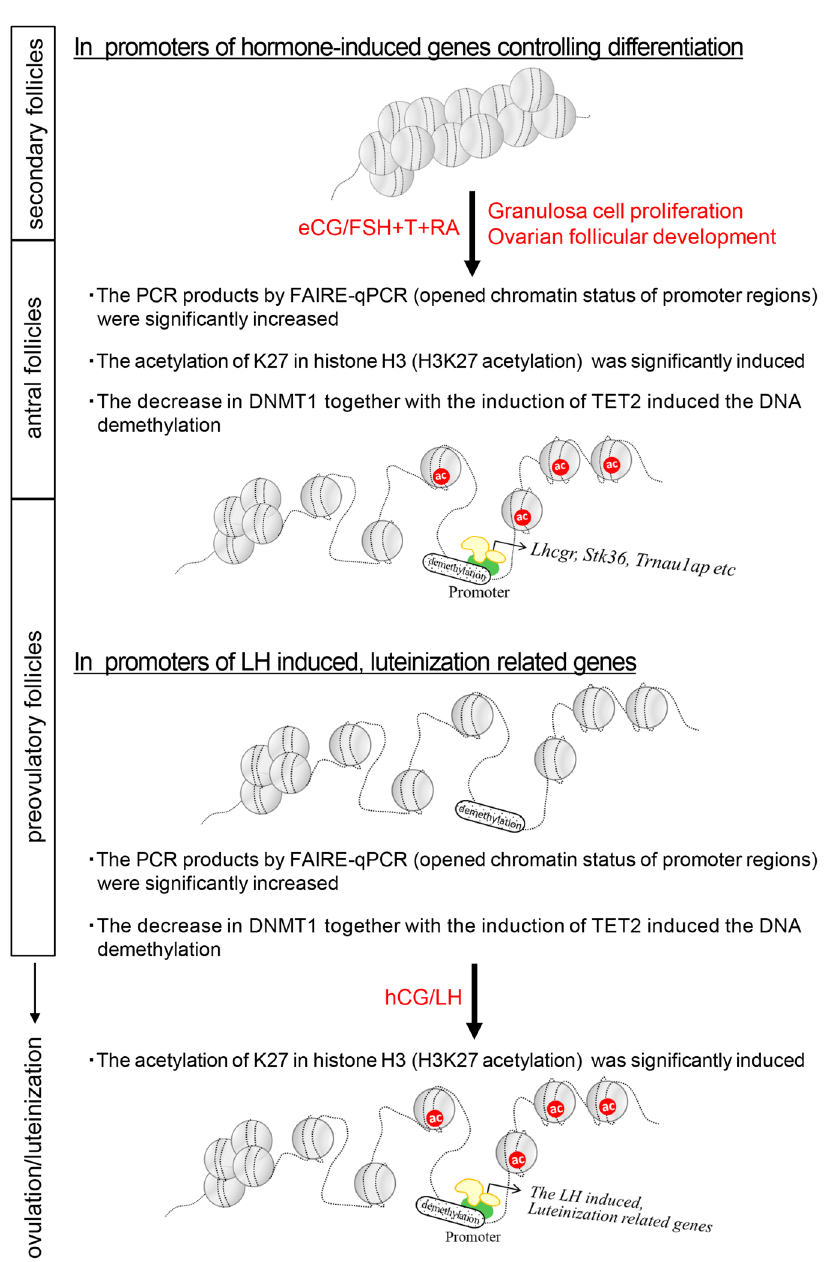
Fig. 7 The roles of retinoic acid (RA) in epigenetic regulation in granulosa cells during follicular development. a The expression of Ccnd2 , Dnmt1 , Tet2 , Lhcgr , Stk36 , and Trnau1ap in cultured granulosa cells. Granulosa cells were collected from ovaries of 3-week-old mice after treatment with eCG for 6 h and were cultured in the absence of serum. FSH (100 ng/ml). T, testosterone (10 ng/ml). RA (1 μ M). Levels of mRNA were normalized to that of L19 . Values are represented as the mean ± SEM ( n = 3 biological replicates). The value of the control (without any factors) was set as 1 and the data are presented as fold induction. *Signi fi cant differences were observed between the control group and the RA and/or FSH + T treatment group ( p < 0.05). b , c The percentage of cells that expressed lower levels of DNMT1 was signi fi cantly increased by RA but decreased by the alcohol dehydrogenase (ADH) inhibitor (4MP). b The dot plot graph of double-positive granulosa cells with DNMT1 and PI during follicular development. c The percentage of cells that expressed lower levels of DNMT1 at S-phase. The lower threshold of DNMT1 levels at S-phase was set as 5% of cells with lower DNMT1 expression in the control group (C; without any factors) (red line). The cells that expressed lower levels of DNMT1 are shown in the red box, and cells with higher DNMT1 expression are shown in the black box at S-phase. Values are represented as the mean ± SEM ( n = 4 biological replicates). *Signi fi cant differences were observed between the control group and the RA treatment group in the presence of FSH + T or the FSH + T treatment group in the presence of 1% FBS ( p < 0.05). Signi fi cant differences were observed compared with those treated with no 4MP ( p < 0.05). Signi fi cant differences in percentage values were